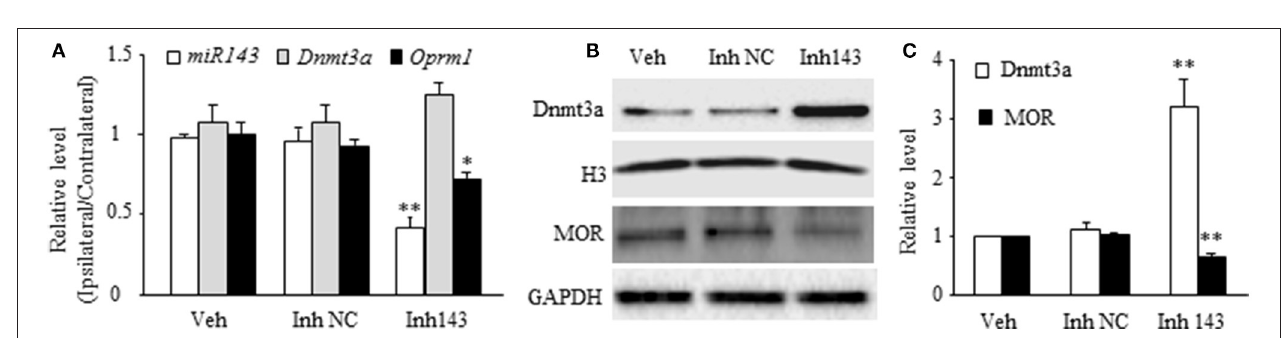
FIGURE 1 | Rescuing miR-143 downregulation blocked the SNL-induced increase in Dnmt3a and restored the SNL-induced decreases in Oprm1 mRNA and MOR in injured dorsal root ganglia (DRG). miR, microRNA; MOR, mu opioid receptor; NC, negative control; SNL, spinal nerve ligation, Veh, vehicle, (A) miR-143 decreased in the ipsilateral, but not contralateral, L5 DRG on days 3 and 7 after SNL, but not sham surgery. n = 6 rats/time points. Two-way ANOVA followed by Tukey post-hoc test. * P < 0.05 vs. the corresponding naive group (0 day). (B,C) Microinjection of miR-143 mimics into the ipsilateral L5 DRG rescued the SNL-induced downregulation of miR-143 (B) , restored the SNL-induced decrease in Oprm1 mRNA (C) , and did not affect the SNL-induced increase in Dnmt3a mRNA (C) in the ipsilateral L5 DRG on day 7 post-SNL. n = 6 rats/group. One-way ANOVA followed by Tukey post-hoc test. * P < 0.05 or ** P < 0.01 vs. the corresponding vehicle plus sham group. ## P < 0.01 vs. the corresponding vehicle plus SNL group. (D) Microinjection of miR-143 mimics into the ipsilateral L5 DRG blocked the SNL-induced increase in Dnmt3a and restored SNL-induced decrease in MOR. Left, representative Western blots; Right, statistical summary of the densitometric analysis; n = 6 rats/group. One-way ANOVA followed by Tukey post-hoc test. ** P < 0.01 vs. the corresponding vehicle plus sham group. # P < 0.05 vs. the corresponding vehicle plus SNL group.